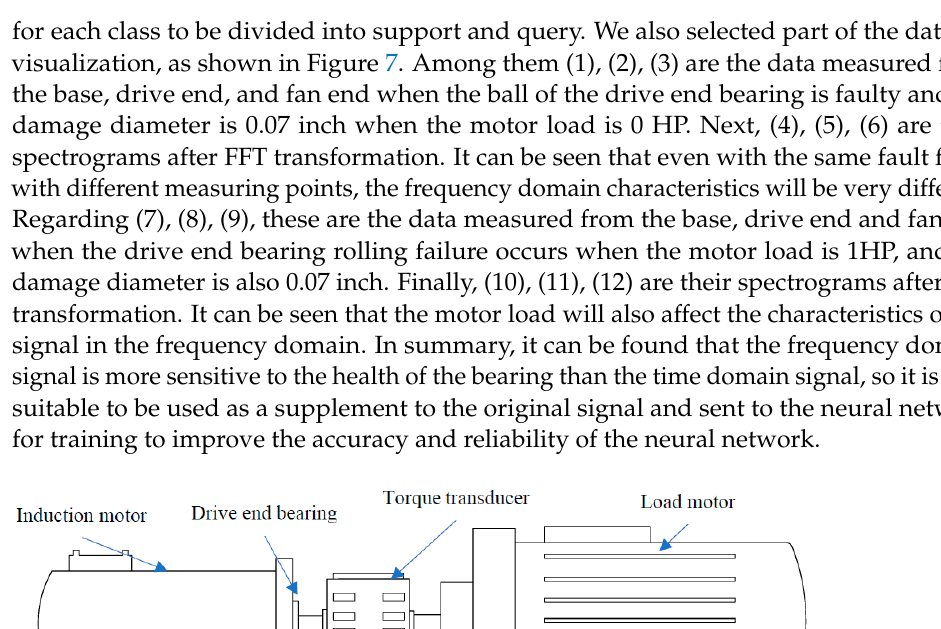
Figure 7. Visualization of a part of training data.